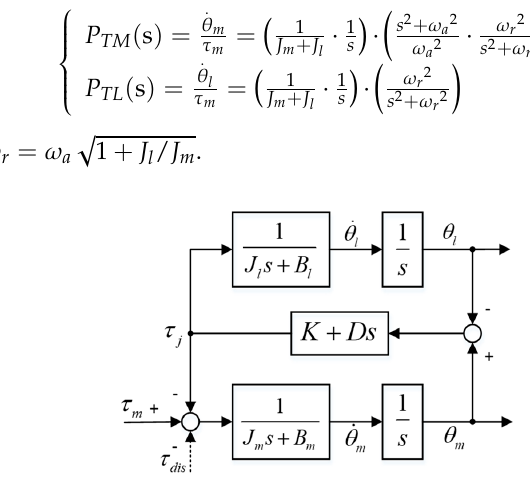
Figure 2. The two-inertia model block diagram of the modular drive joint.